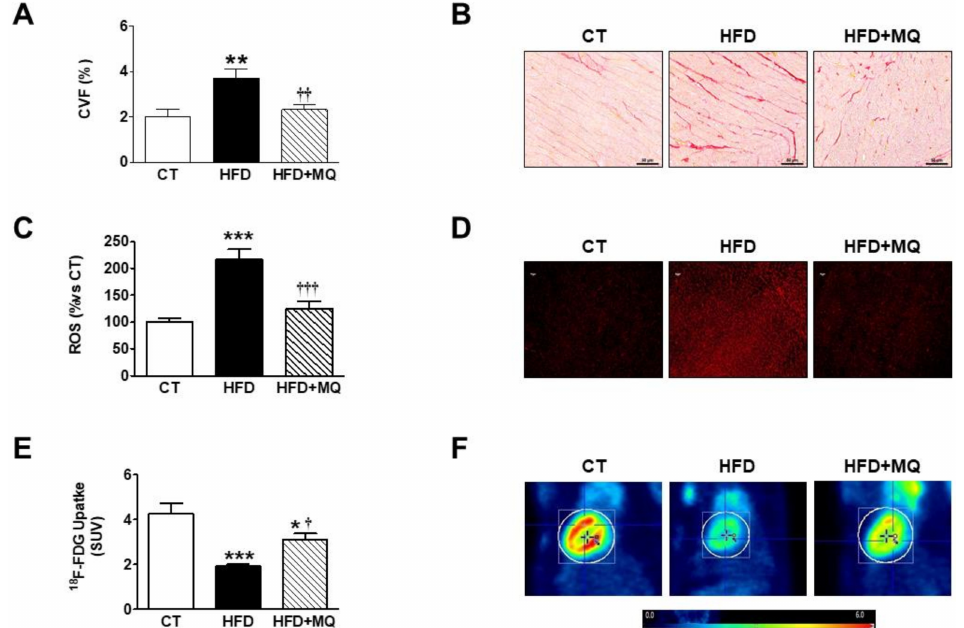
Figure 1. E ff ects of the mitochondrial antioxidant MitoQ (MQ) on cardiac interstitial fibrosis, superoxide anion levels and cardiac 18 -FDG uptake in obese rats. Hearts from rats fed a standard diet (CT) or a high fat diet (HFD) treated with vehicle or with MQ (200 µ M) were analyzed. ( A ) Quantification of collagen volume fraction (CVF) and ( B ) representative microphotographs of sections stained with picrosirius red. ( C ) Quantification of total cardiac levels of superoxide anion and ( D ) representative microphotographs of cardiac sections labeled with DHE. ( E ) Quantification of myocardial 18 -FDG uptake and ( F ) Representative photographs of 18 F-Fluorodeoxyglucose (FDG) PET / CT scans in trans-axial views scaled to standardized uptake value (SUV). Magnification ( × 40).Bar graphs represent the mean ± SEM. of 6–8 animals. * p < 0.05; ** p < 0.01; *** p < 0.001 vs. control group. † p < 0.05; †† p < 0.01; ††† p < 0.001 vs. HFD